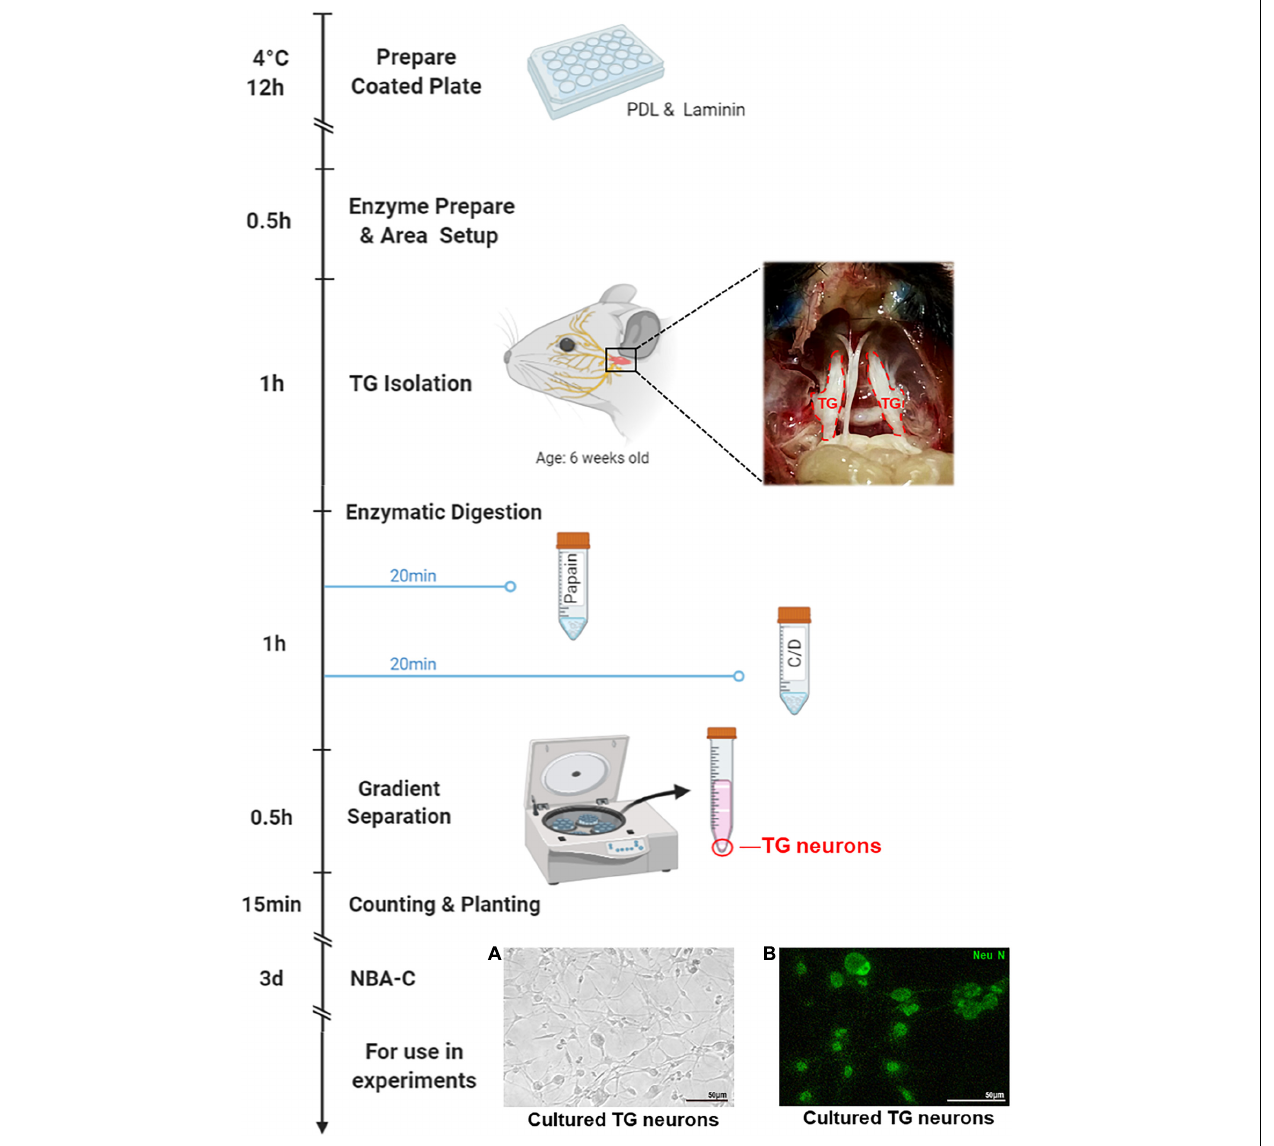
FIGURE 1 | Isolation process of the TG neurons. Plate or coverslips were coated with PDL and Laminin the day before neuron isolation, followed by overnight incubation. Neuron isolation should take a total of 3.5 h. This process includes 0.5 h of setup, < 1 h to isolate TGs, < 1 h of enzymatic digestions (20 min each, with additional time for spinning down), and 1 h to separate, wash, count, and seed the neurons. The following step is > 1 h of incubation, and then 3 days of culture in Neurobasal-A Complete (NBA-C), at which point the neuron cultures are ready for later use in experiments. This figure was created with BioRender.com. (A) TG neurons cultured for 3 days were observed under white light. (B) Immunofluorescence of TG neurons cultured for 3 days stained with the neuronal marker NeuN